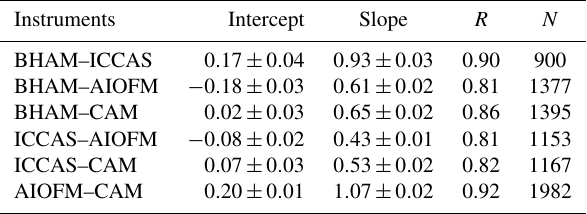
Table 6. RMA regression relationships (with 95% confidence in- tervals) of HONO measured by all instruments in the middle of the summer campaign (7–14 June 2017). Note that BHAM and ICCAS inlets were in same location for this period. The CAM instrument had moved to the same container as AIOFM, whose inlets were 3m apart. Variability shown is the 95% confidence interval of the slope and intercepts.